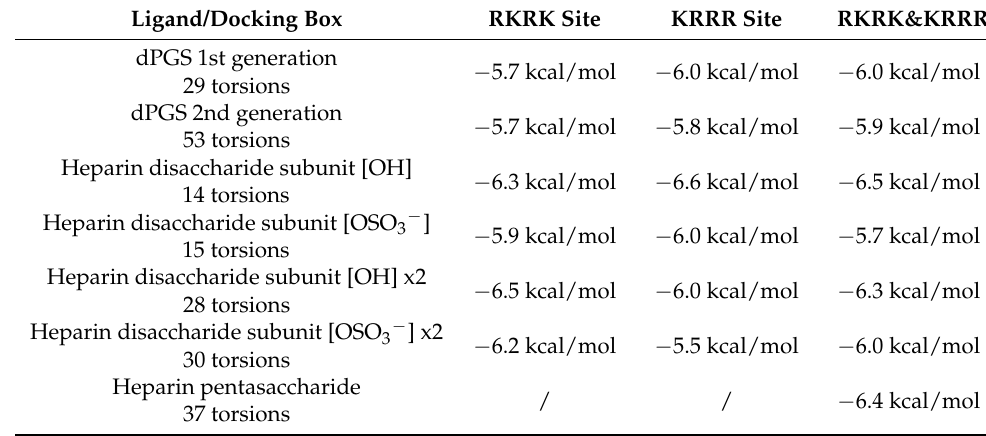
Table 1. Summary of the binding affinities of the most favorable docking positions of ligands to hIL-6. For each ligand number of bonds that were rotated during the docking is stated.